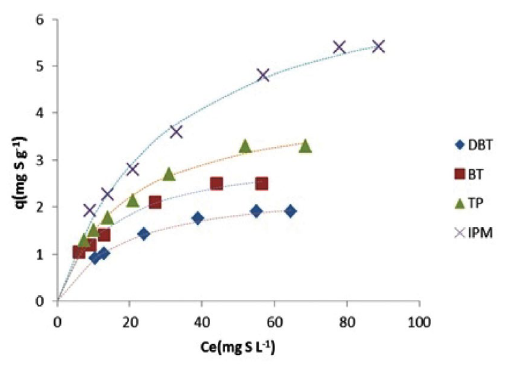
Fig. 9. The isotherms obtained at 20 °C for TP, BT, DBT and IPM sulfur containing molecules using the D1.5 sample. Dashed lines show the simulated curves based on the Langmuir-type